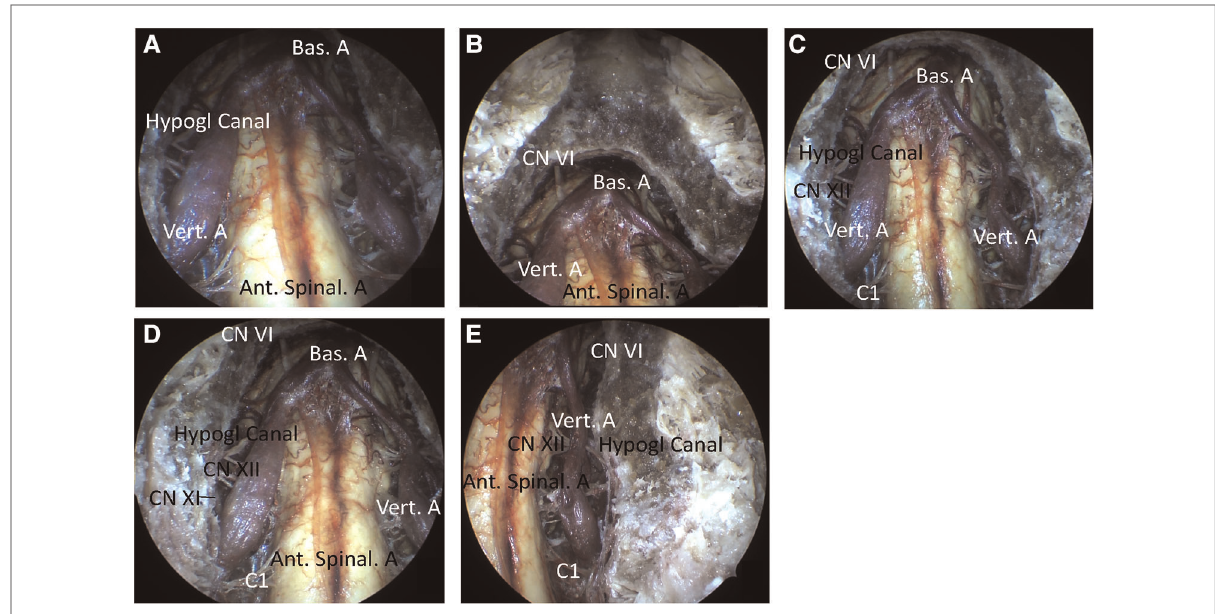
FIGURE 4 The view of the resection of the clivus, atlas, and dens. ( A ) The view of the 0° endoscope. ( B ) The view of the 30° endoscope (cranial). ( C ) The view of the 30° endoscope (caudal). ( D ) The view of the 30° endoscope (right). ( E ) The view of the 30° endoscope